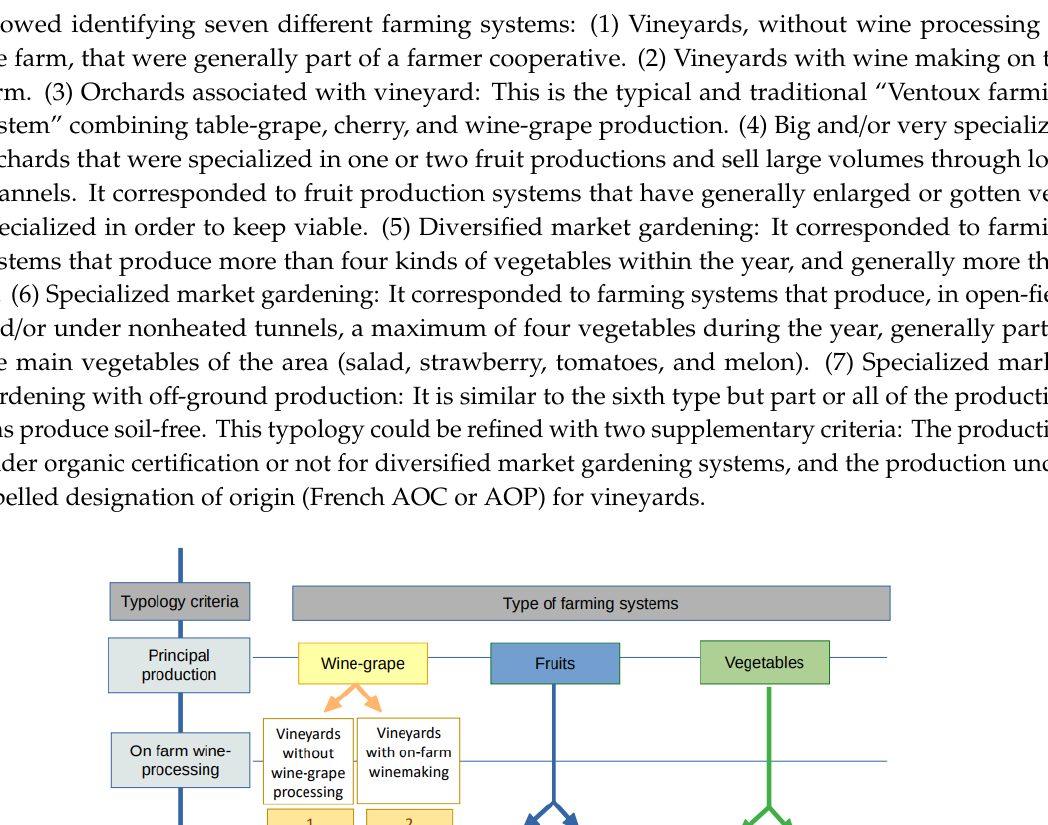
Table 2. Farming system trajectories.